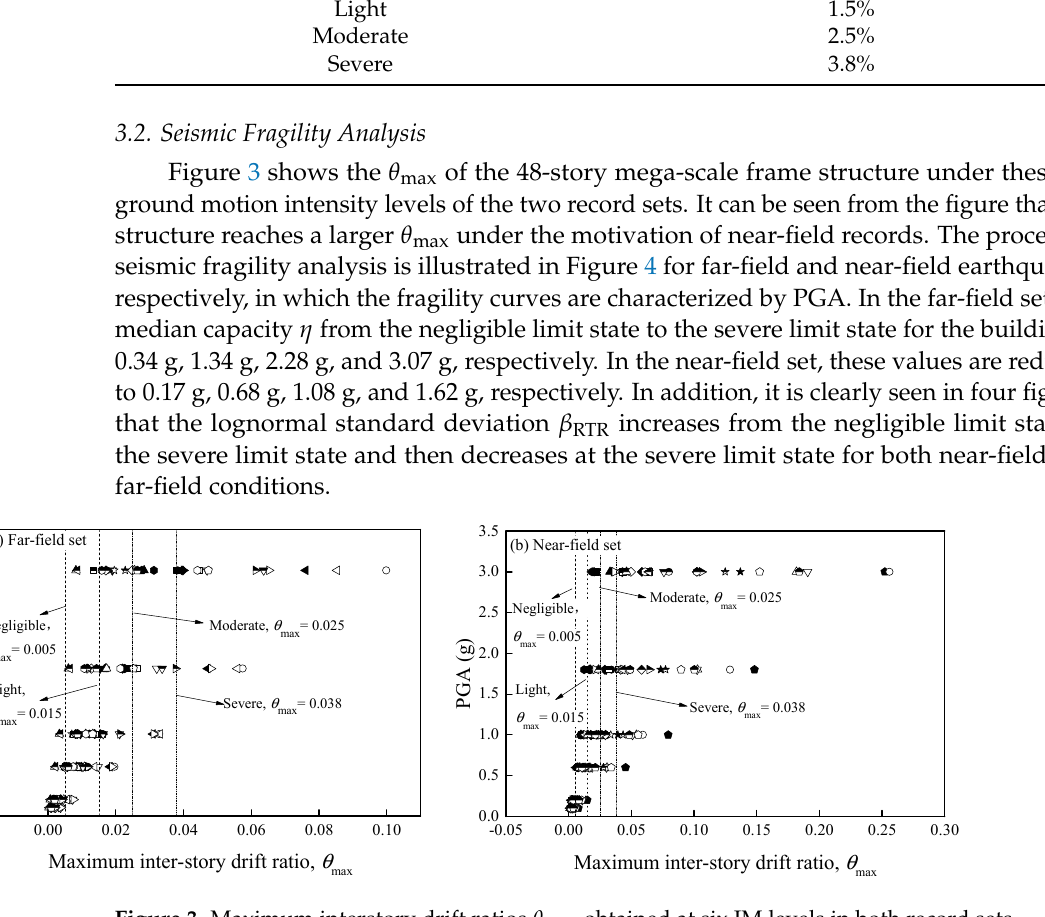
Figure 4. Fragility curves characterized by PGA for the four damage limit states in cases of far-field and near-field sets. 4. Influence of IMs on the Estimation of Fragility Curves 4.1. Comparative Analysis between PGA and S a (T 1 ) Ground motion intensity IMs have important effects on the results of probabilistic analysis based on seismic fragility; that is, they affect the correlation between seismic hazard intensity level and structural damage. Figure 4 shows that the discreteness represented by PGA is obviously high, and the β RTR value is approximately 0.6. S a ( T 1 ) are used here for fragility comparative analysis with PGA. As shown in Figure 5, when the PGA is converted to S a ( T 1 ), each record has a different seismic intensity level. Note that, to obtain the fragility curves using the MSA method, n j in Equation (1) is fixed to 1. When θ max is larger than the threshold of the corresponding limit state, the probability of exceeding the limit state is set to 1.